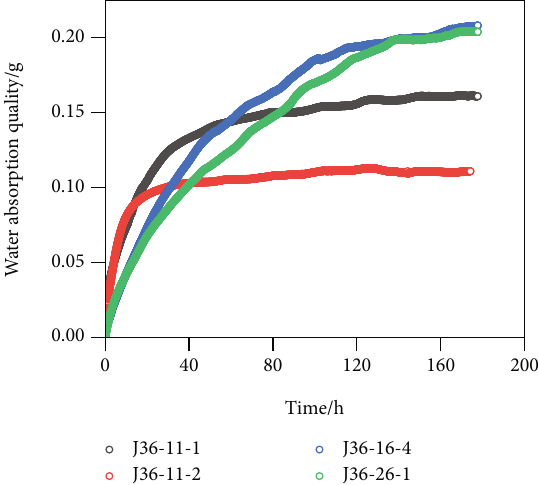
Figure 12: Spontaneous imbibition curve of J36 borehole in